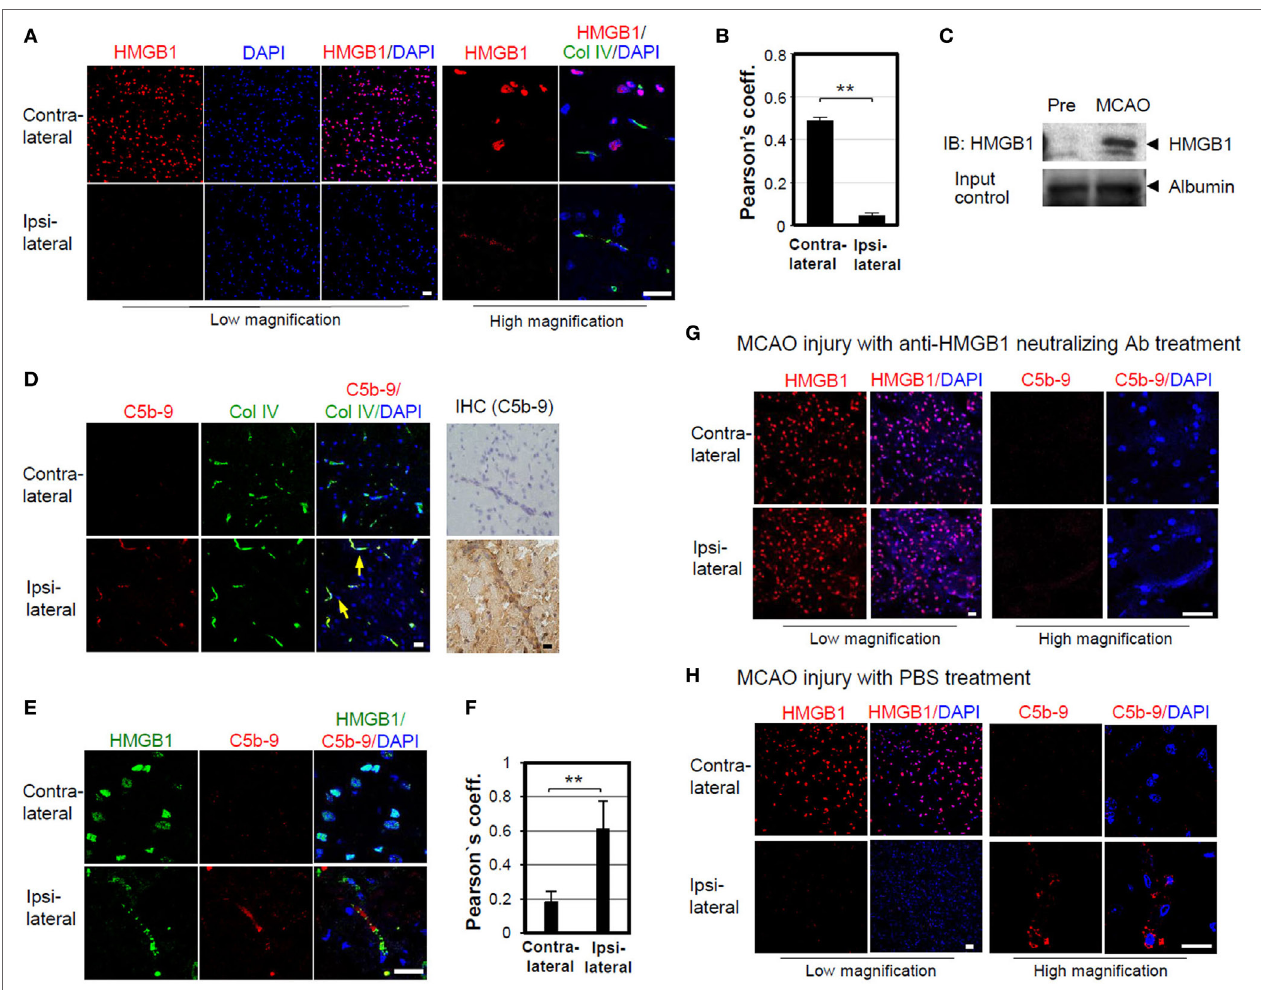
FigUre 5 | Membrane attack complex (MAC) deposition is reduced by high-mobility group box 1 (HMGB1) neutralizing antibody (Ab) in middle cerebral arterial occlusion (MCAO) ischemia mouse model. (a) HMGB1 staining of ICR mouse brain 4 h after MCAO. Contralateral and ipsilateral brain sections were stained for HMGB1 and collagen (Col) IV, which visualizes most blood vessels and capillaries. The images captured at low and high magnifications are shown. (B) Pearson’s coefficient for the overlapping of HMGB1 and DAPI in low magnification of three fields was calculated. Error bars are mean ± SD. ** P < 0.01 by Student’s paired t -test. (c) Serum HMGB1 was detected using Western blot analysis after MCAO. (D) Sublytic MAC deposition (arrow) was observed in mouse brain, 4 h after MCAO. Brain sections were immunostained against C5b-9 for confocal microscopy and immunohistochemistry. (e) Brain sections were stained against HMGB1 and sublytic MAC after MCAO, and their colocalization could be detected in the ipsilateral brain region. (F) Pearson’s coefficient for overlapping of HMGB1 and sublytic MAC of 42 random visual fields was calculated. Error bars are mean ± SD. ** P < 0.01 by Student’s paired t -test. (g,h) Mice were intravenously injected with anti-HMGB1 neutralizing Ab (100 μ g/mouse) or PBS 4 h after MCAO reperfusion injury. Mouse brain sections were immunostained for HMGB1 (low magnification) and MAC deposition for detail observation (high magnification). All scale bars, 20 µm. Four mice were used for the